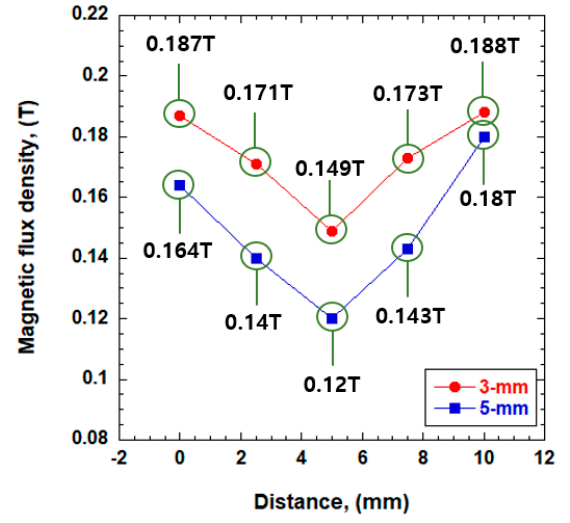
Figure 7. Magnetic flux density (T) vs. distance for different finishing gaps.